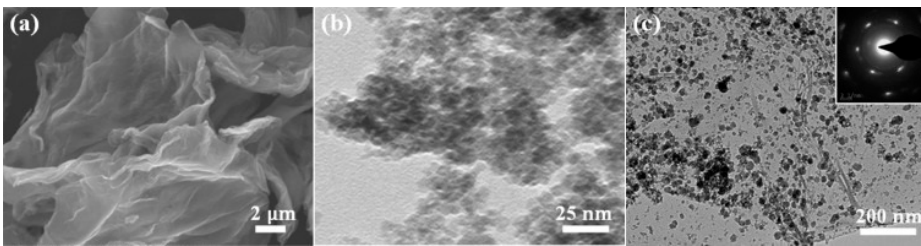
Figure 10. The response of four kinds of sample to to 100 ppm ethanol. Sensors 2019 , 19 , x